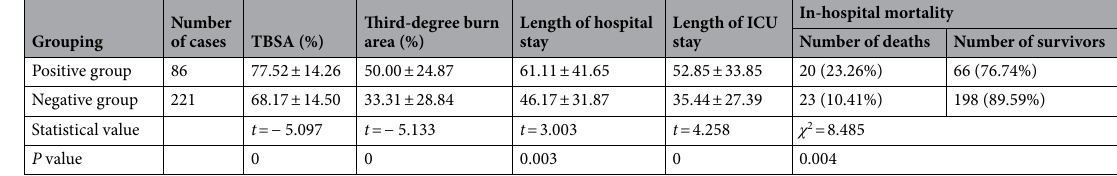
Table 3. Relationship between blood culture results and the prognosis of burn